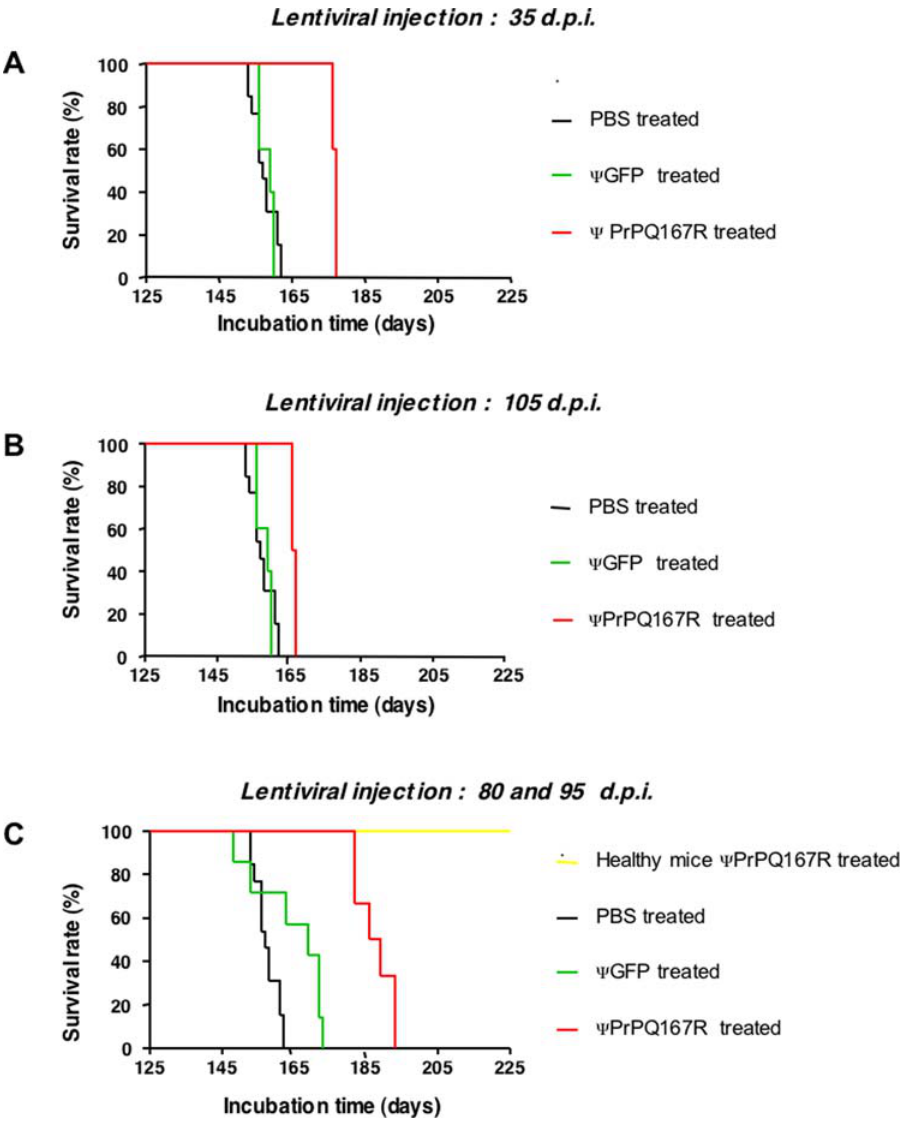
Figure 2. Kaplan-Meier survival plots of C57Bl/6J mice treated with lentiviral vectors. Mice inoculated with ME7 prion strain were administered with either : ( A ) one unique injection of PBS or Y GFP or Y PrPQ167R at 35 days p.i.; ( B ) one unique injection of PBS or Y GFP or Y PrPQ167R at 105 days p.i.; ( C ) two injections of PBS or Y GFP or Y PrPQ167R at 80 and 95 days p.i., through a cannula implanted in the mice brain. Healthy mice were treated with Y PrPQ167R at 80 and 95 days p.i.